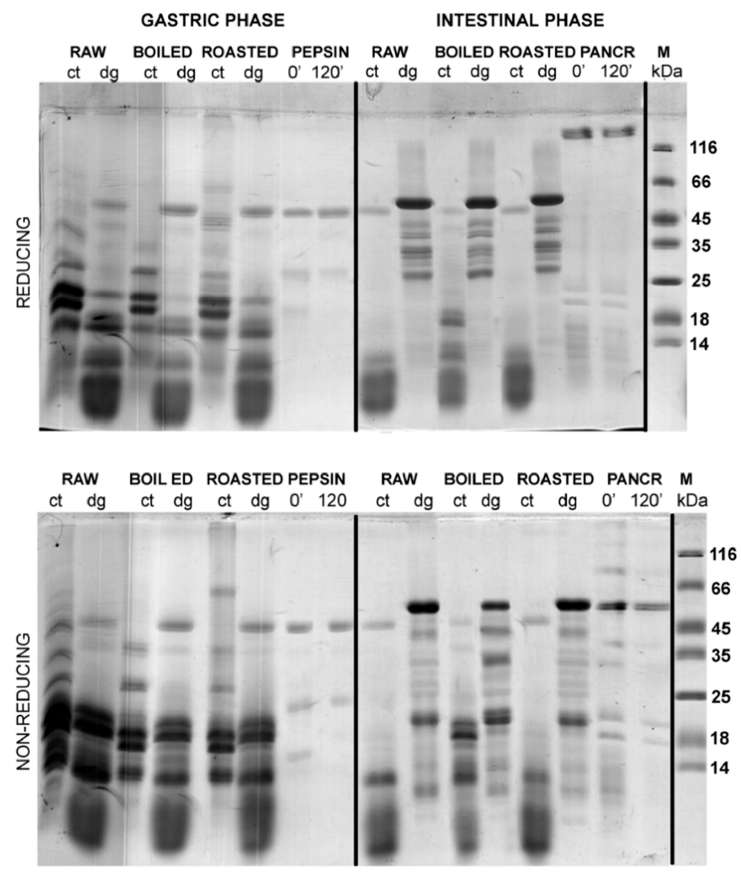
Figure 3. SDS-PAGE protein profiles of n-hexane-defatted raw, boiled, and roasted peanut gastric and intestinal digests and corresponding controls. SDS-PAGE was performed in reducing and non-reducing conditions on 14% gels. ct—control at 120 min; dg—digest at 120 min; PEPSIN—controls containing only pepsin at 0 and 120 min; PANCR—controls containing only pancreatin at 0 and 120 min; M—molecular weight markers.